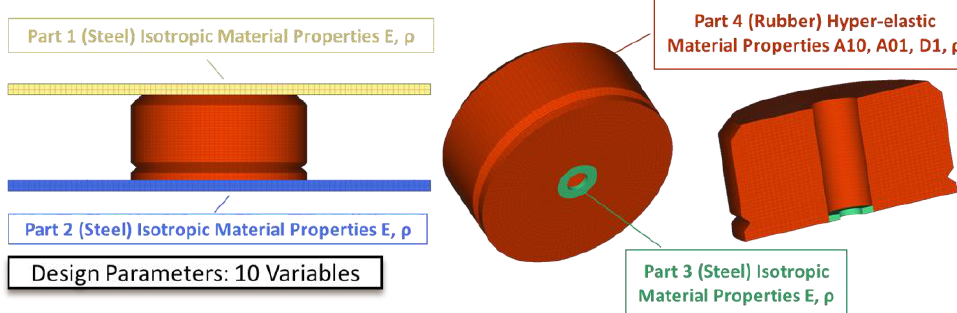
Figure 3. Parts of the parameterized FE model.